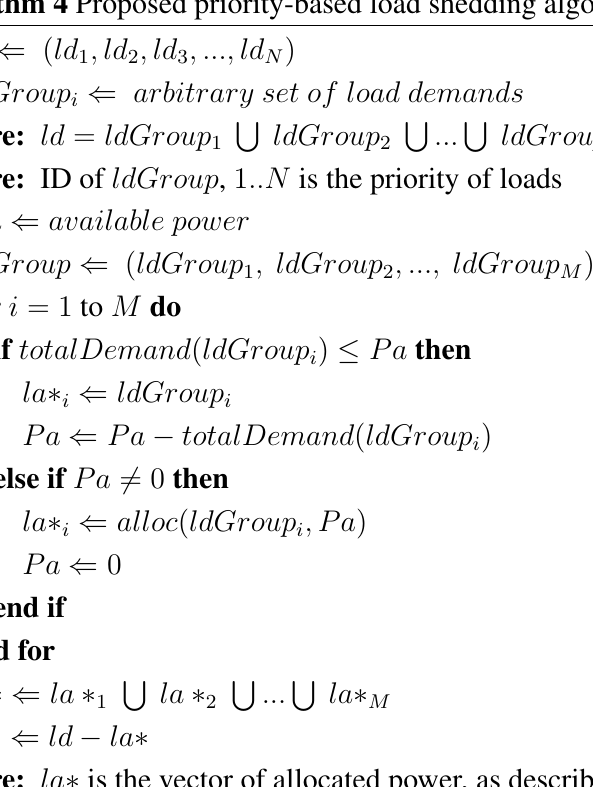
Algorithm 4 Proposed priority-based load shedding